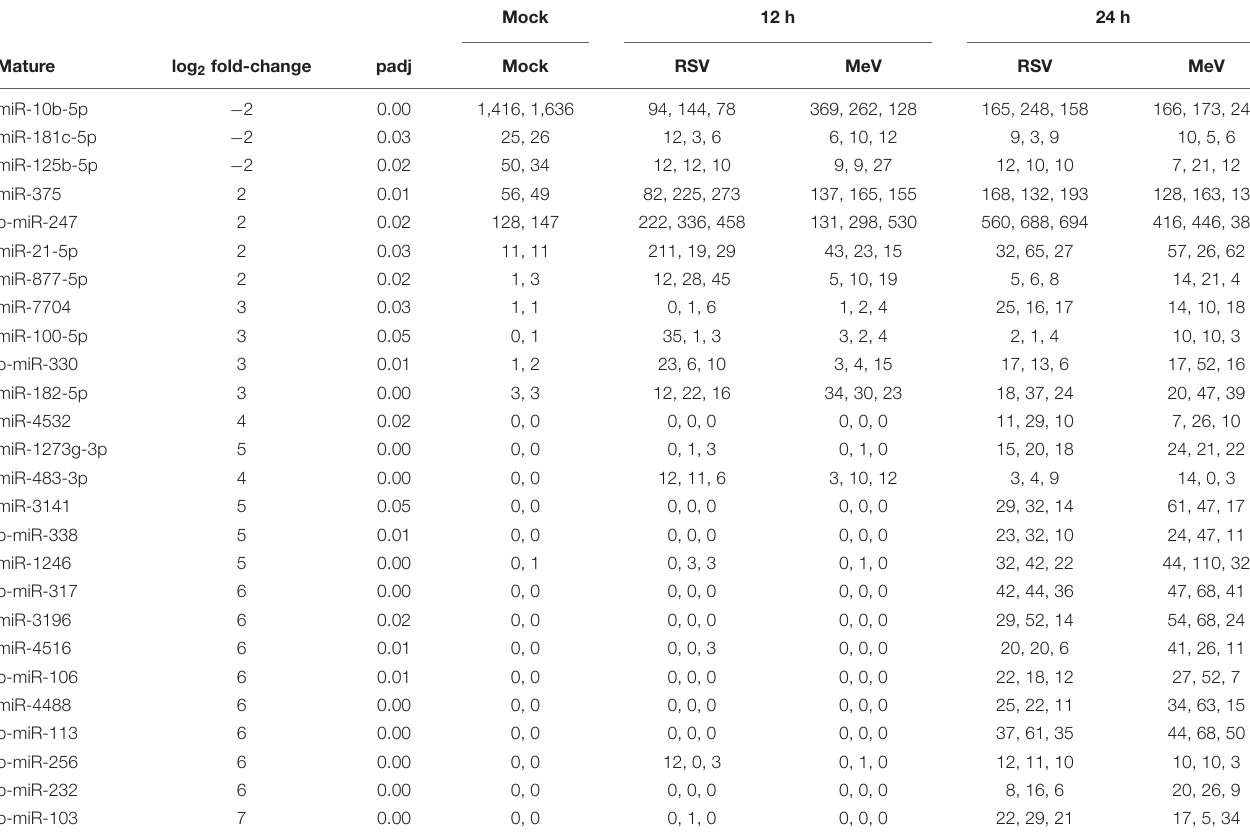
TABLE 2 | Normalized read counts between mock, RSV- and MeV-infected samples as analyzed by OASIS 2.0 (Rahman et al., 2018a). Mock 12 h 24